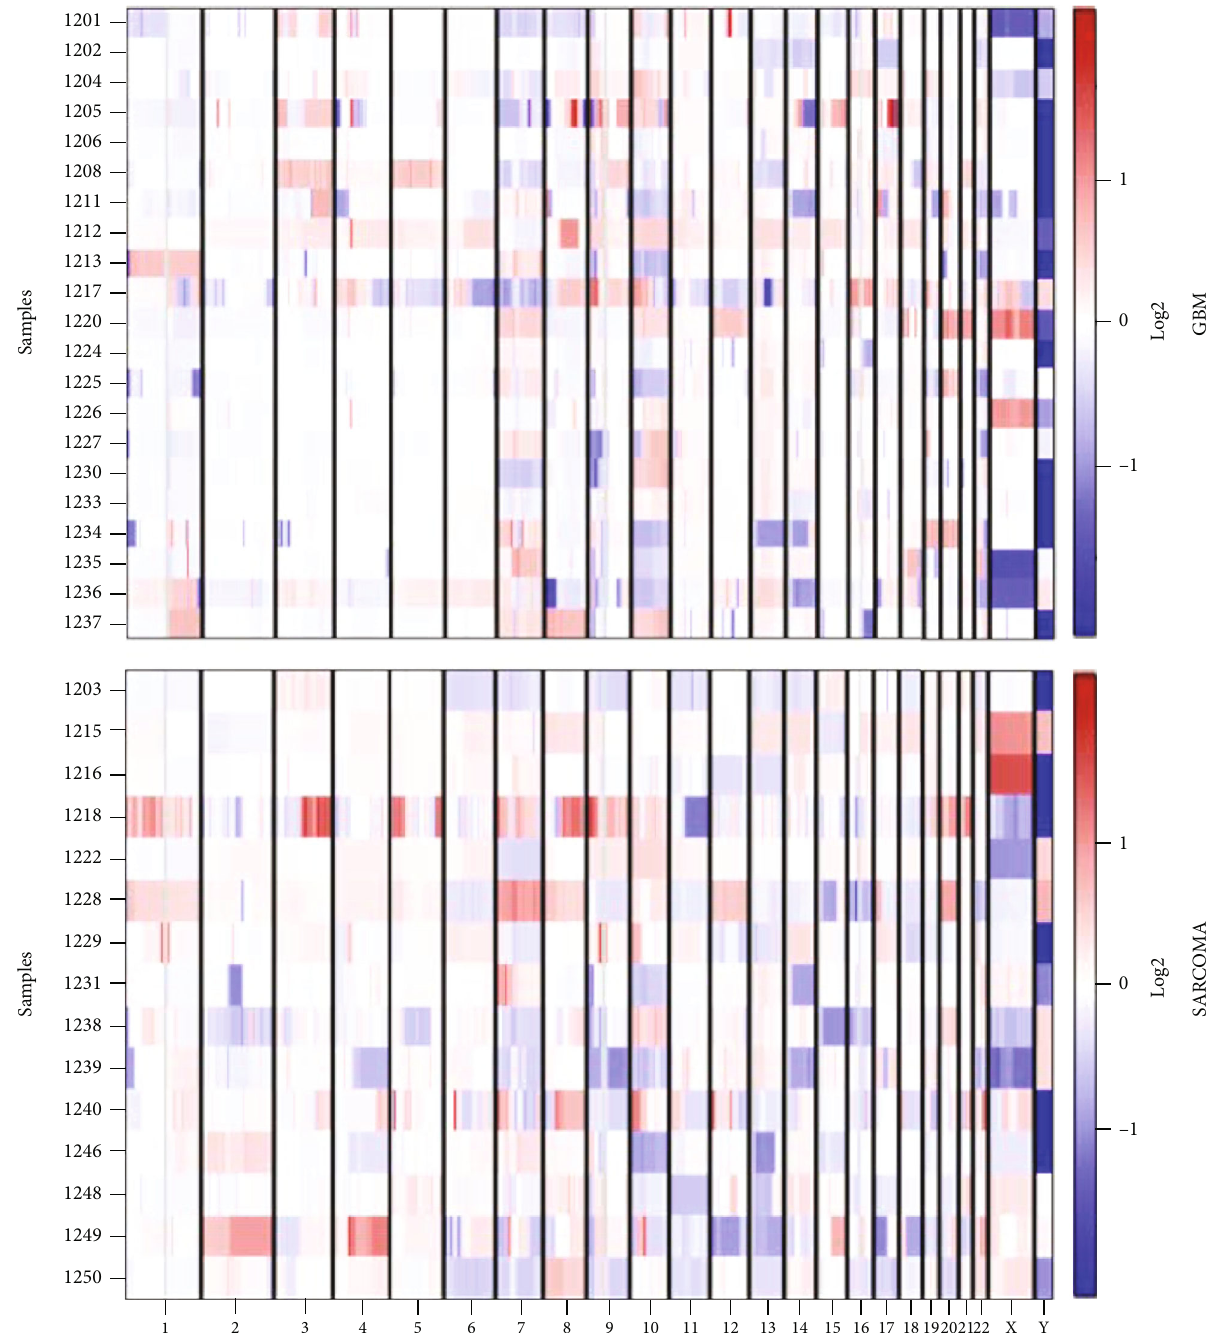
Figure 1: The distribution of genes with CNV on chromosomes. 21 cases of GBM and 15 cases of